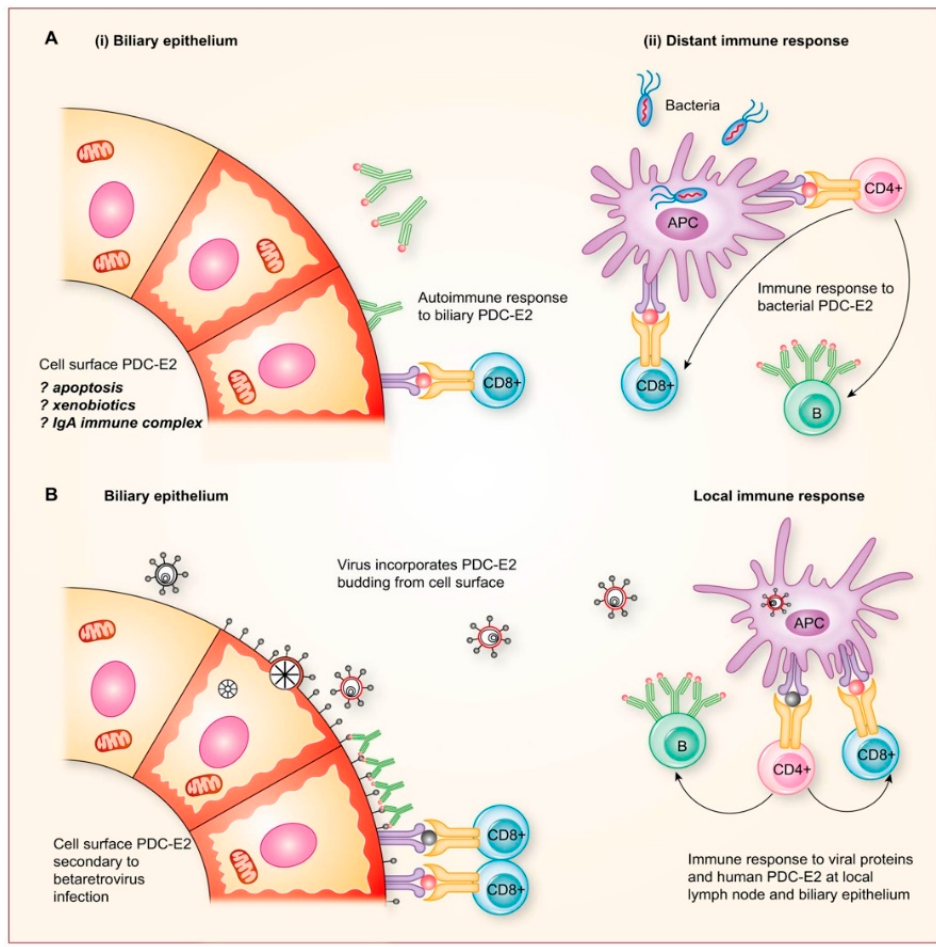
Figure 3. ( A ) Model for generation of autoimmune responses to PDC-E2 with bacterial infection: (i) in a two-hit process, biliary epithelial cells present PDC-E2-like proteins on the biliary epithelium; and (ii) bacterial infection results in PDC-E2 presentation on antigen-presenting cells (APC) breaking tolerance to human PDC-E2 [arrows represent T cell help]. The subsequent autoimmune response homes in on the aberrant expression of PDC-E2 in biliary epithelium [? represents factors that may precipitate cell surface PDC-E2]. ( B ) In a single-hit process, human betaretrovirus infects biliary epithelium leading to PDC-E2 expression on the cell surface. The virus either incorporates PDC- E2 while budding from the cell surface or exits with PDC-E2 in exosomes (not shown). APCs then present PDC-E2 and viral proteins, resulting in a bystander immune response to PDC-E2 and an immune response to viral and self-proteins expressed on biliary epithelium (Adapted from Wasilenko et al. [95] with